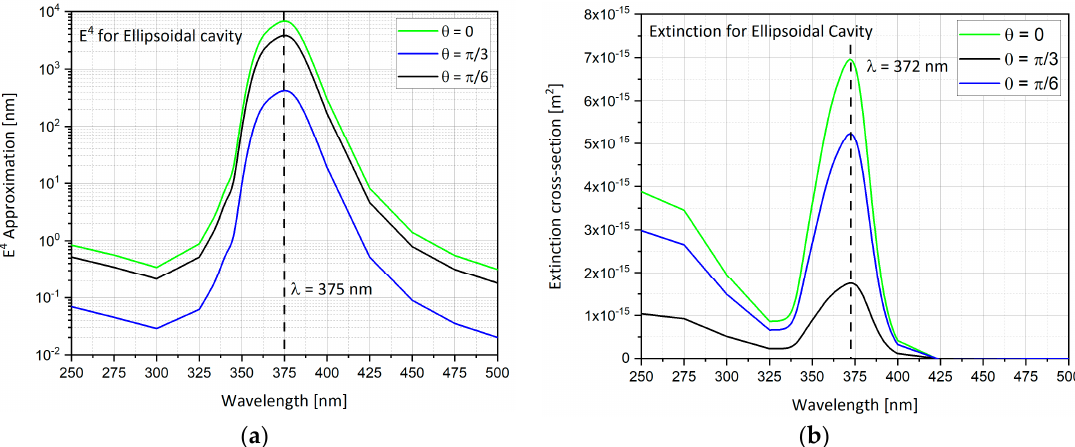
Figure 9. Ellipsoidal cavity results while changing the polar angle θ in a wavelengths range of λ = 250–500 nm. ( a ) E 4 approximation; ( b ) extinction cross-section.